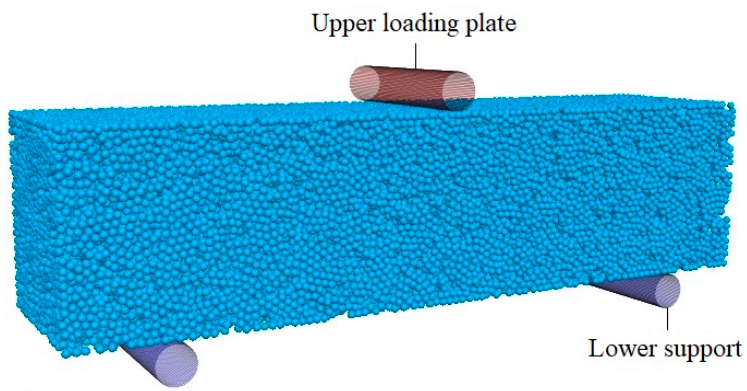
Figure 29. A numerical model for the three-point flexural test.